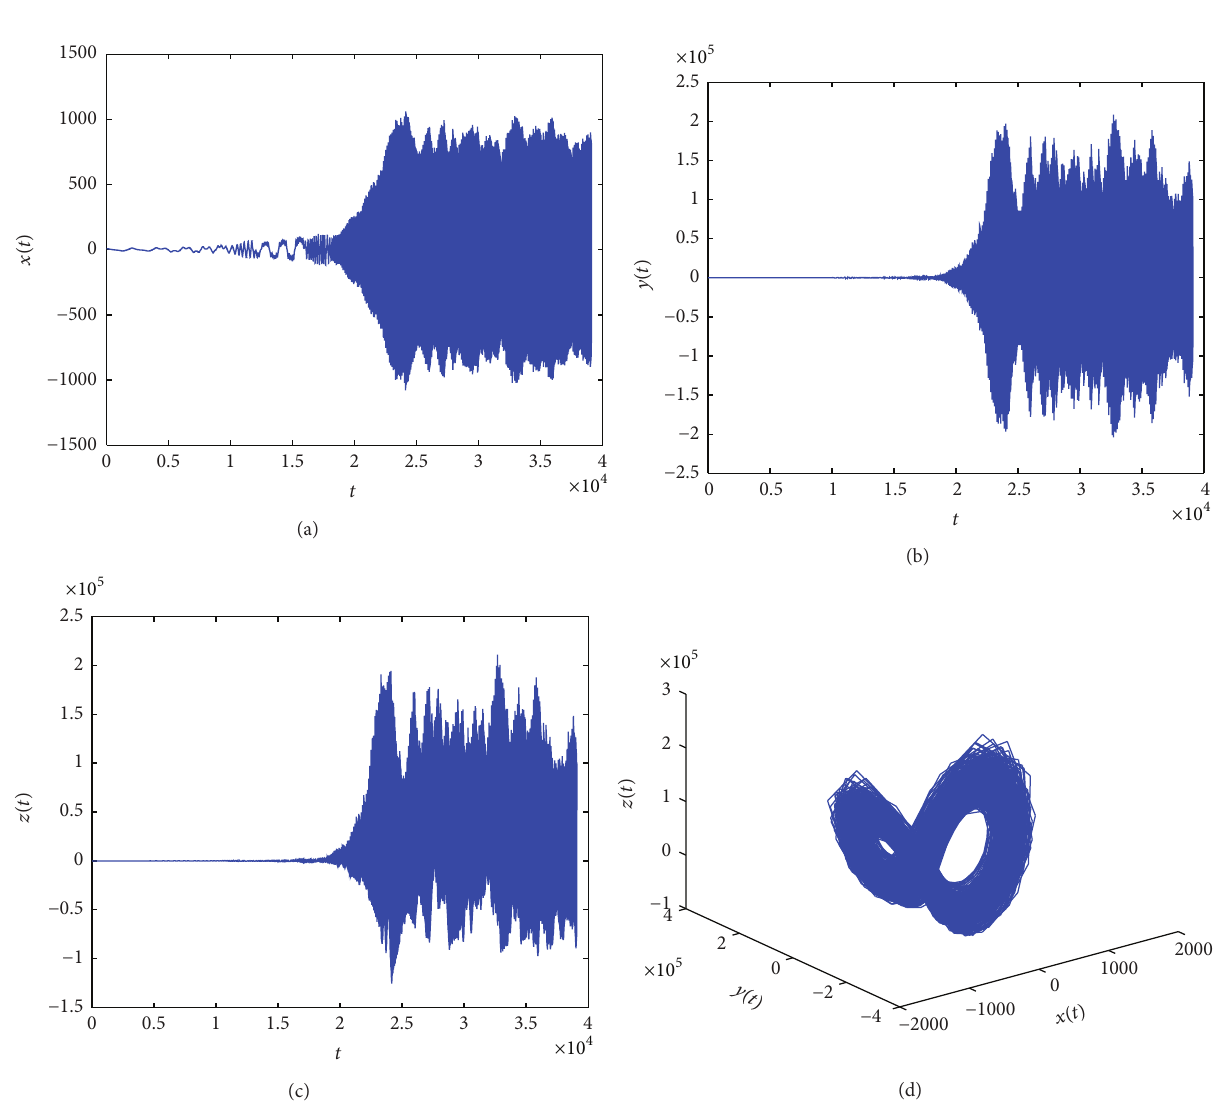
Figure 4: The trajectories and the phase graph of system (83) with 𝑇 = 100 , 𝜀 = 0.326 , and 𝜏 = 0.4 ; 𝐸 ∗ 2 is unstable, and a rank one strange attractor